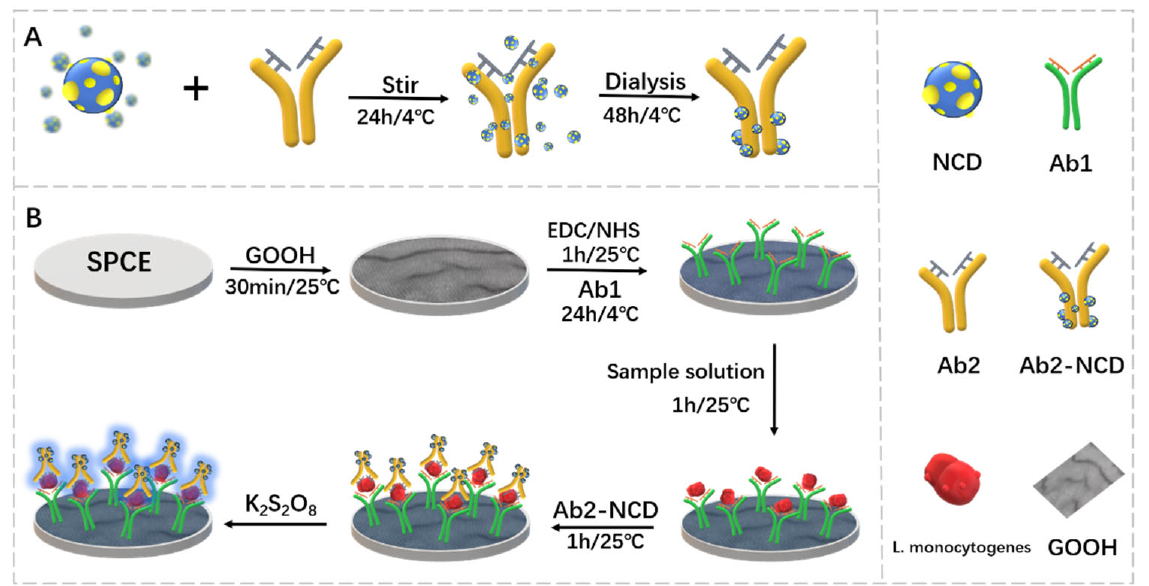
Figure 6. Schematic of ( A ) NCD conjugated with secondary antibody and ( B ) the developed ECL sensor for monocytic bacteria (Adapted with permission from Ref. [24]. 2021, Jampasa et al.).